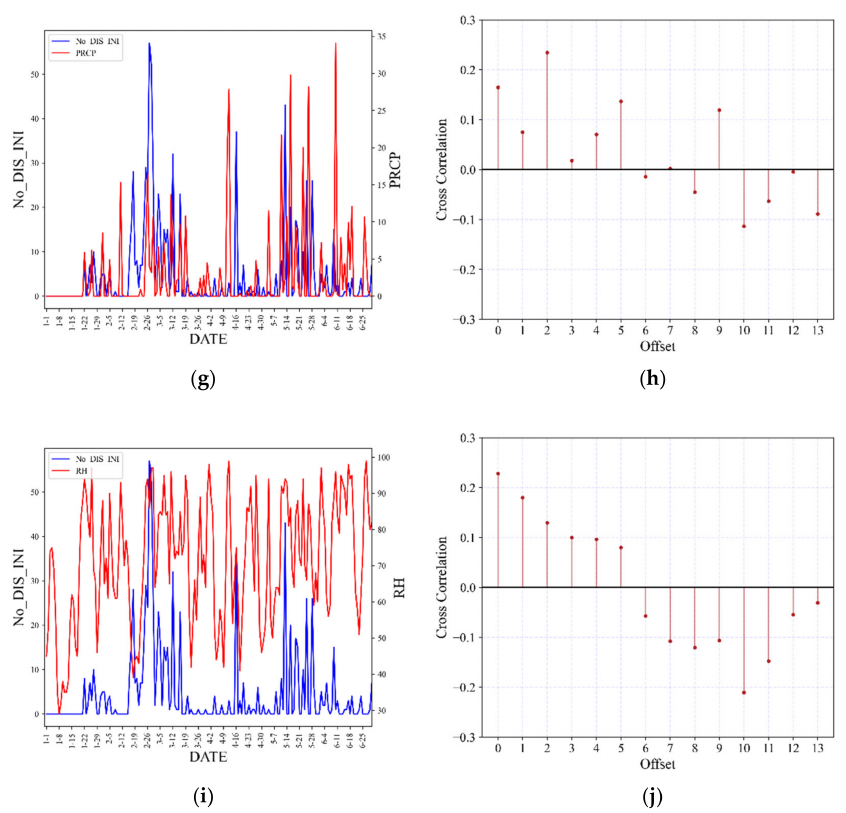
Figure 4. Daily cumulative number of distress initiations (No_DIS_INI) and meteorological variables (left column) and TLCC charts between the cumulative daily number of distress initiations and mete- orological variables (right column). ( a ) Comparison of No_DIS_INI and daily maximum temperature; ( b ) TLCC between No_DIS_INI and daily maximum temperature; ( c ) Comparison of No_DIS_INI and daily minimum temperature; ( d ) TLCC between No_DIS_INI and daily minimum temperature; ( e ) Comparison of No_DIS_INI and daily average temperature; ( f ) TLCC between No_DIS_INI and daily average temperature; ( g ) Comparison of No_DIS_INI and daily total precipitation; ( h ) TLCC between No_DIS_INI and daily total precipitation; ( i ) Comparison of No_DIS_INI and relative humidity; ( j ) TLCC between No_DIS_INI and relative